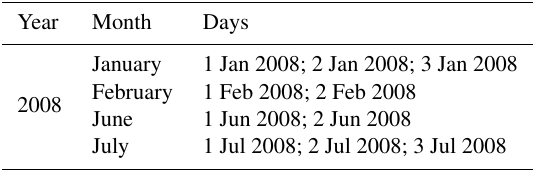
Table 5. CloudSat-CALIPSO observations used in this